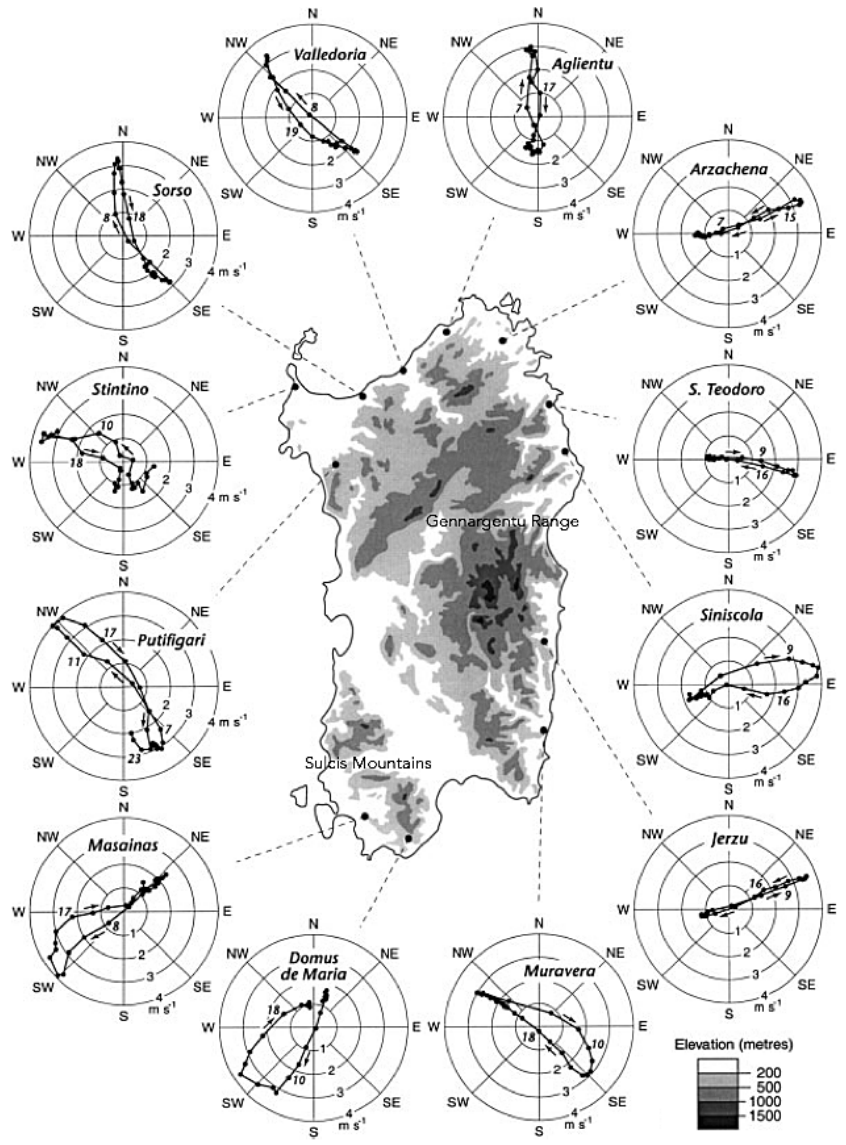
Figure 1. Topographic map of Sardinia with 12 coastal stations and SB hodographs. The island is approximately 270km long and 140km wide; from Furberg et al.